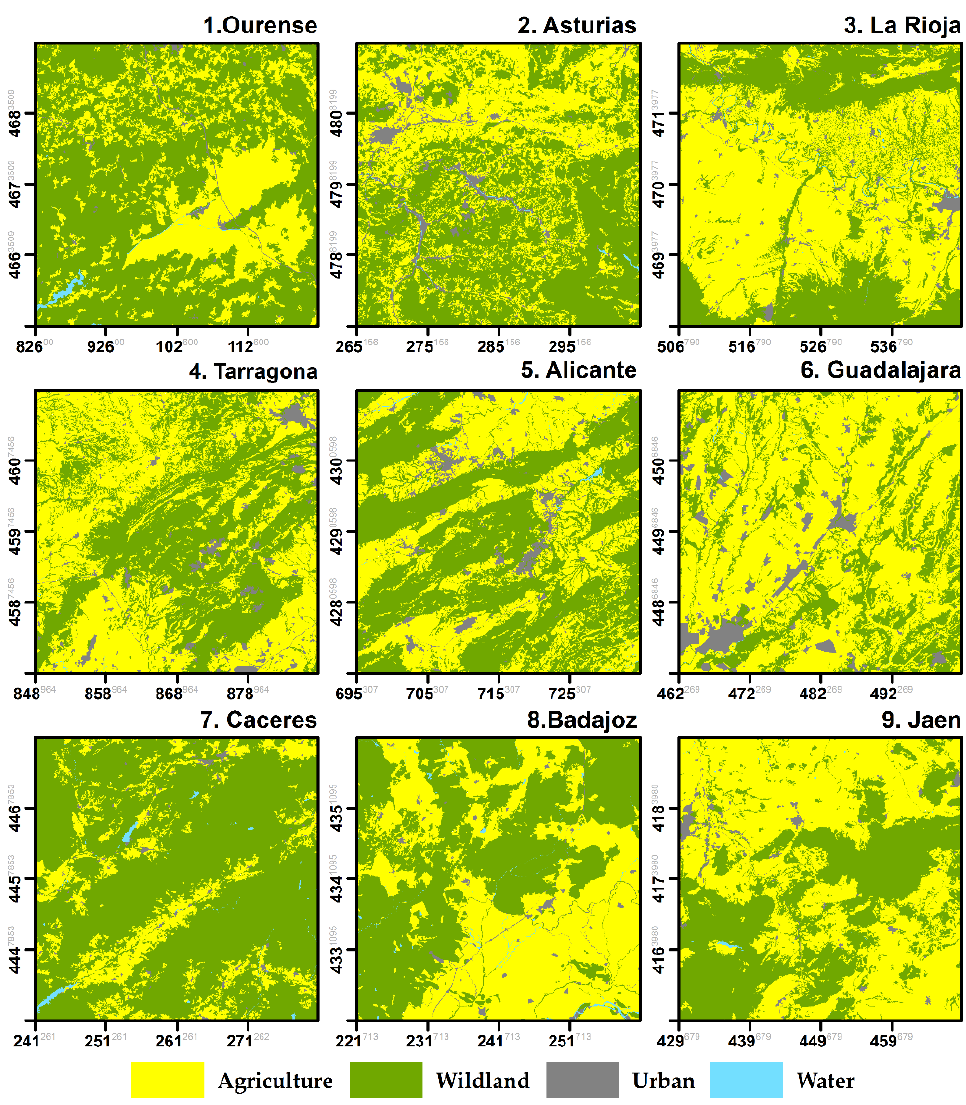
Figure 2. Land use map of the study areas.